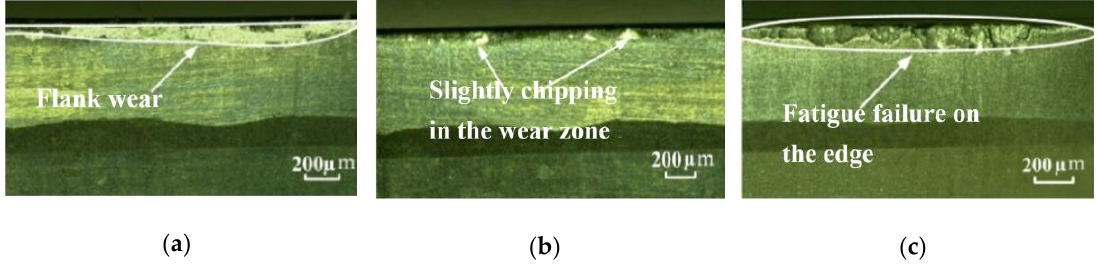
Figure 9. Tool failure morphology of 6# cutter insert at different cutting times: ( a ) t = 32 min; ( b ) t = 56 min; ( c ) t = 58 min.